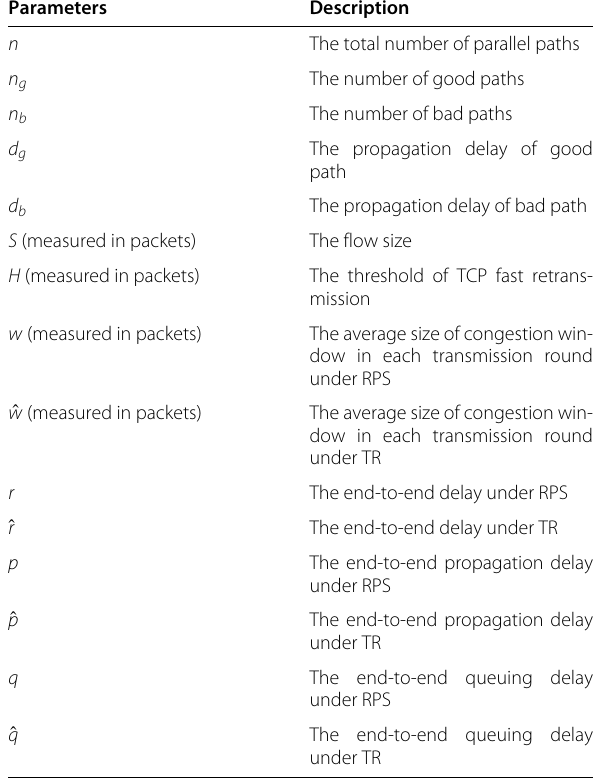
Table 3 Parameters used in model